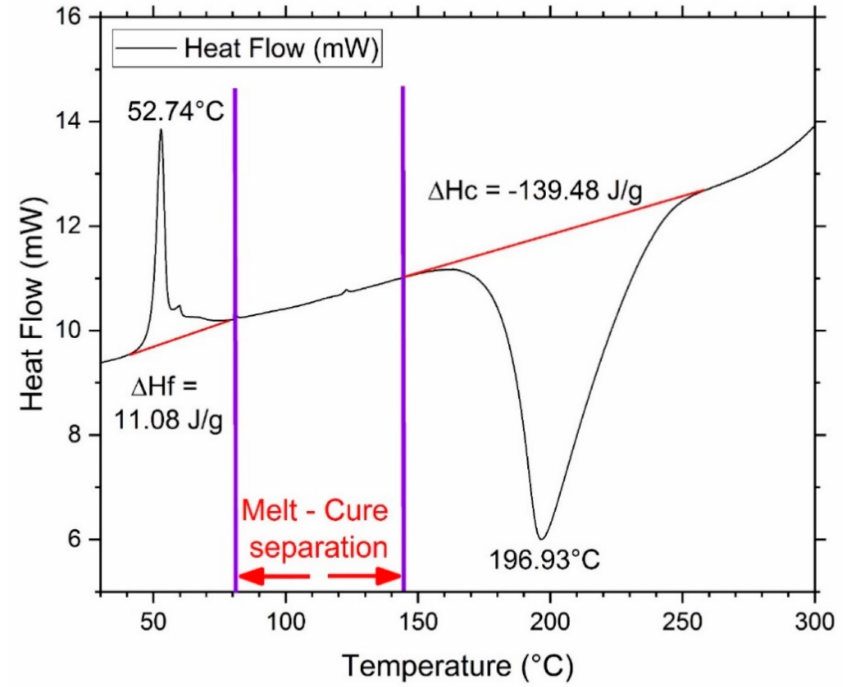
Figure 1. Differential scanning calorimetry showing a temperature sweep of (20 ◦ C/min) of PE6405. The temperature gap between the end of the melt and beginning of the cure is represented by purple lines